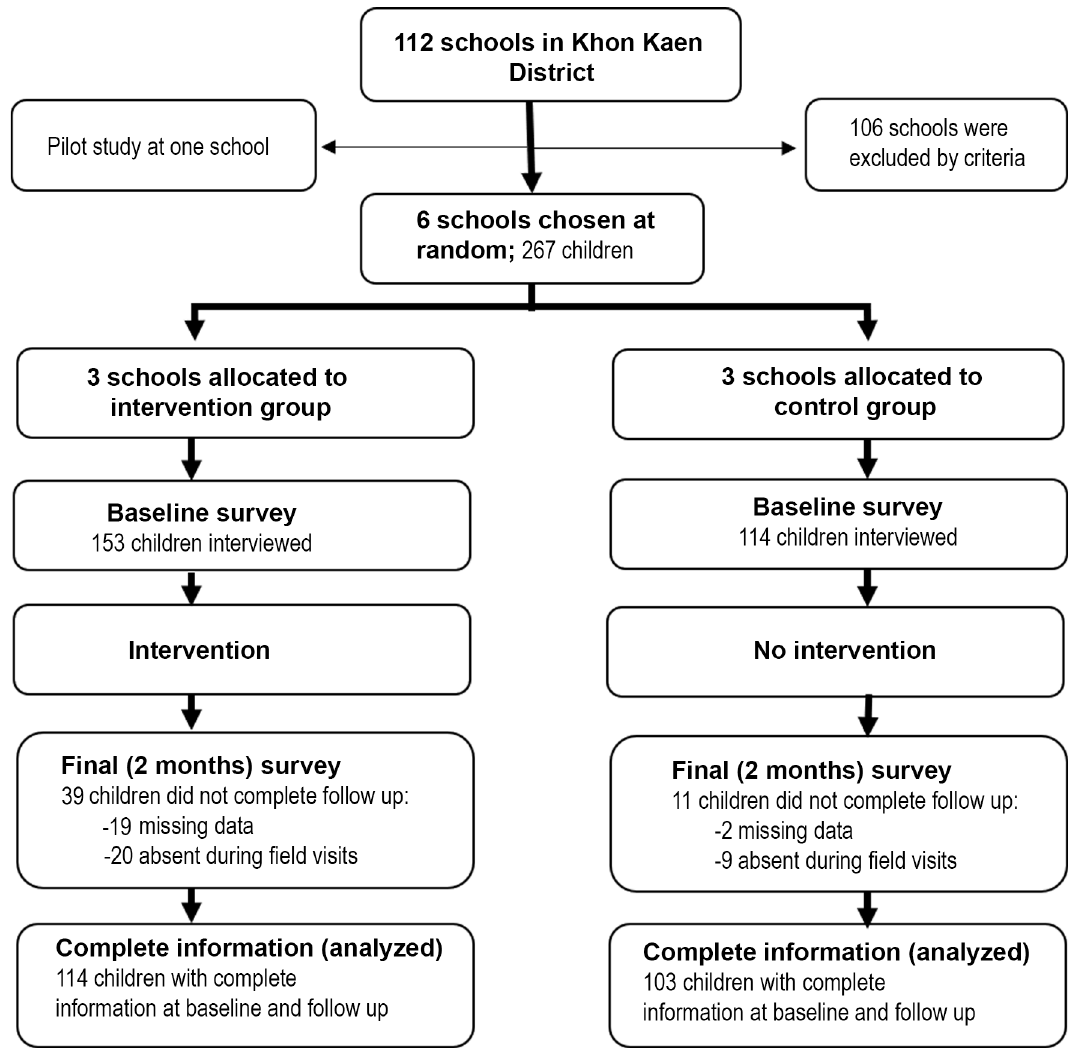
Fig 1. Flow chart for study. Six schools were chosen at random and assigned to intervention or control groups. The health education program was provided to the intervention group. Head lice infestation was investigated at baseline and at two months after